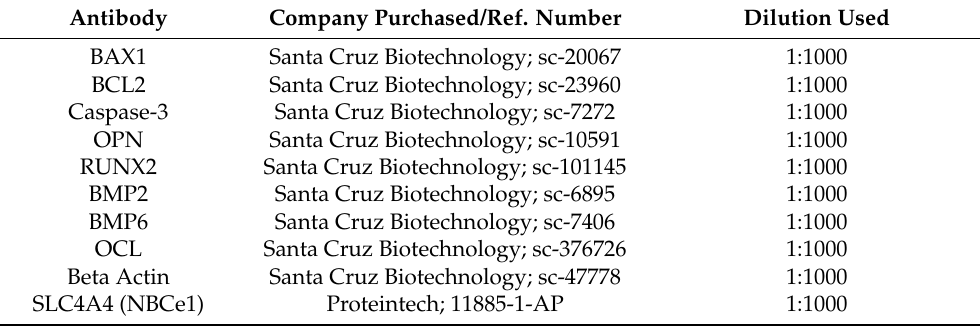
clonal antibodies (Table 2). Anti-mouse secondary antibodies from Sigma-Aldrich and ECL kit from Pierce (Invitrogen) were used. Table 2. Antibody information. Antibody Company Purchased/Ref.